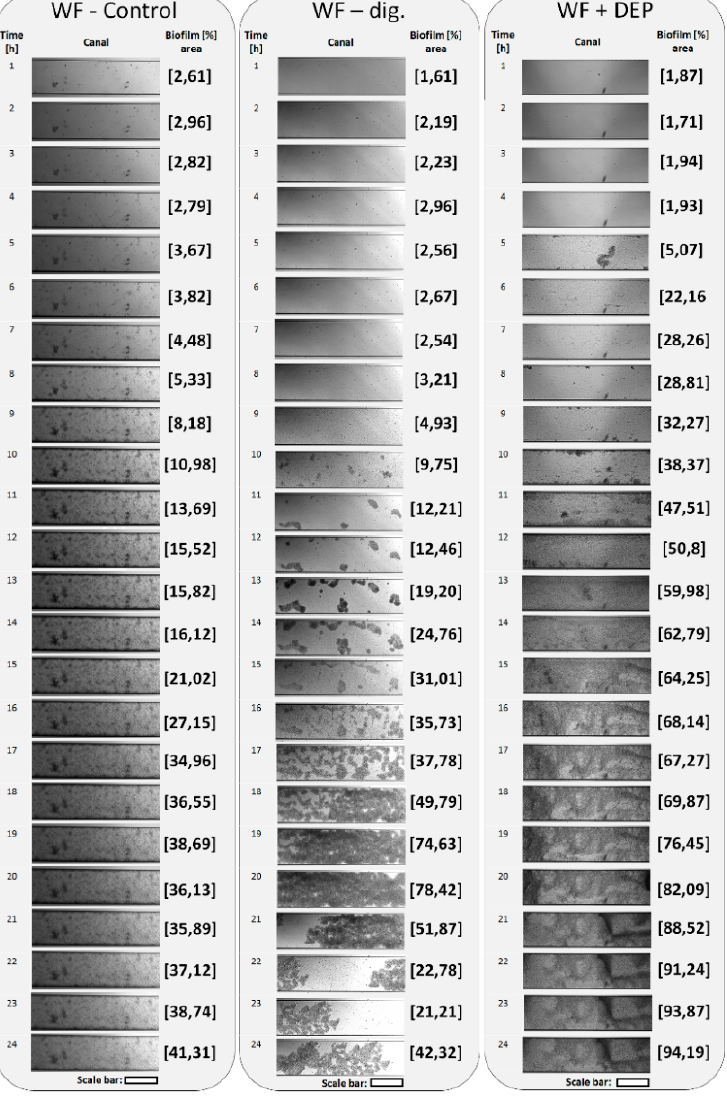
Figure 9. Imaging of the channel cross section microfluidic system for microbiome of bioreactor samples during 24 h of incubation at flow conditions (0.5 dyn cm 2 ). Biofilms formed by microorganisms were visualised using differential interference contrast (DIC); scale bar = 100 µm.